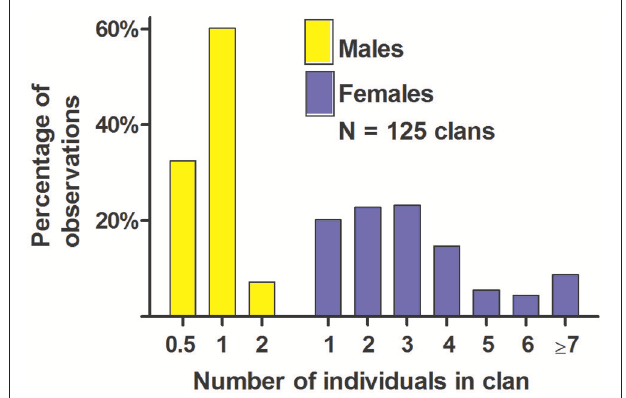
FIGURE 4 | Number of sexually mature males and sexually mature females in clans of white-tailed prairie dogs at the Arapaho National Wildlife Refuge, Colorado USA, in June of each year from 2006 through 2012. These data are only from clans with ≥ 1 female (i.e., we have not included solitary males). For males, “0.5” refers to a territory (and group of females) in which a male spent some of his time; he spent the rest of his time in a different territory with a different group of females; we call each group of females in this scenario a “half-male” clan. One or two sexually immature yearling males sometimes live within clans, but are not shown here. Not every clan produced ≥ 1 weaned litter each spring.